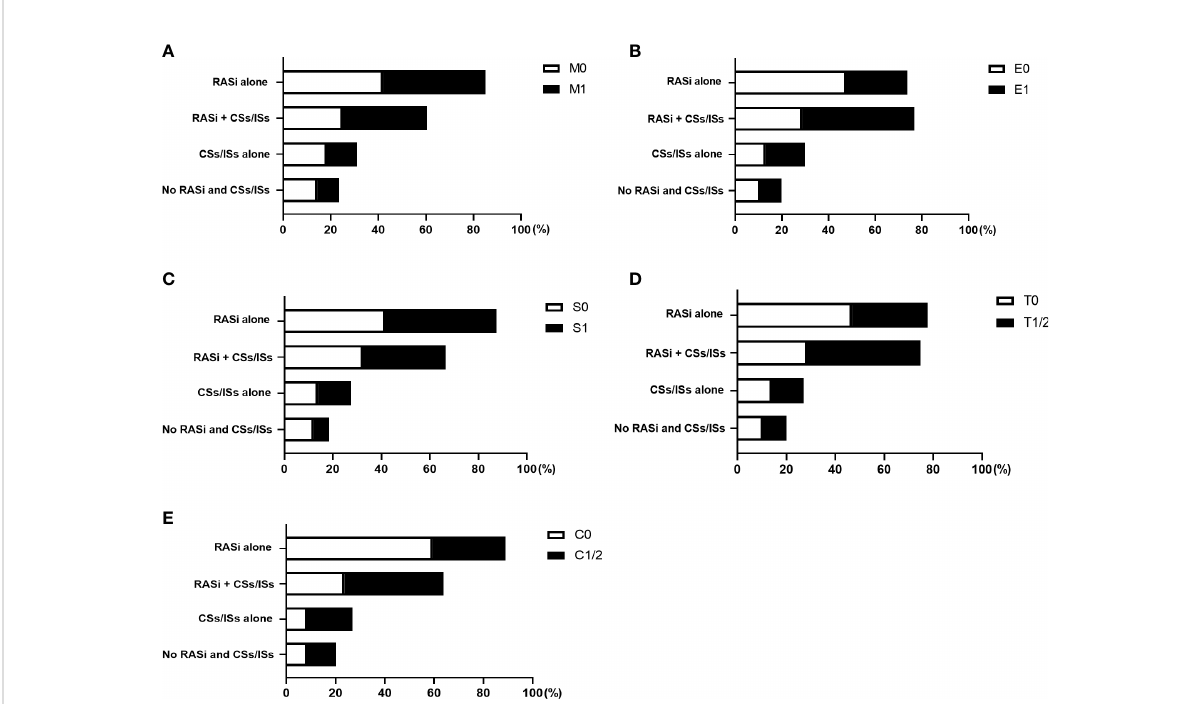
FIGURE 2 Treatments of patients with different Oxford Classi fi cation MEST-C scores. The proportion of patients took renin-angiotensin system inhibitors (RASi) alone, RASi in combination with corticosteroids and (or) immunosuppressants (CSs/ISs), CSs/ISs alone, as well as no RASi and CSs/ISs, in patients with and without M (A) , E (B) , S (C) , T (D) , C (E) lesions were shown.